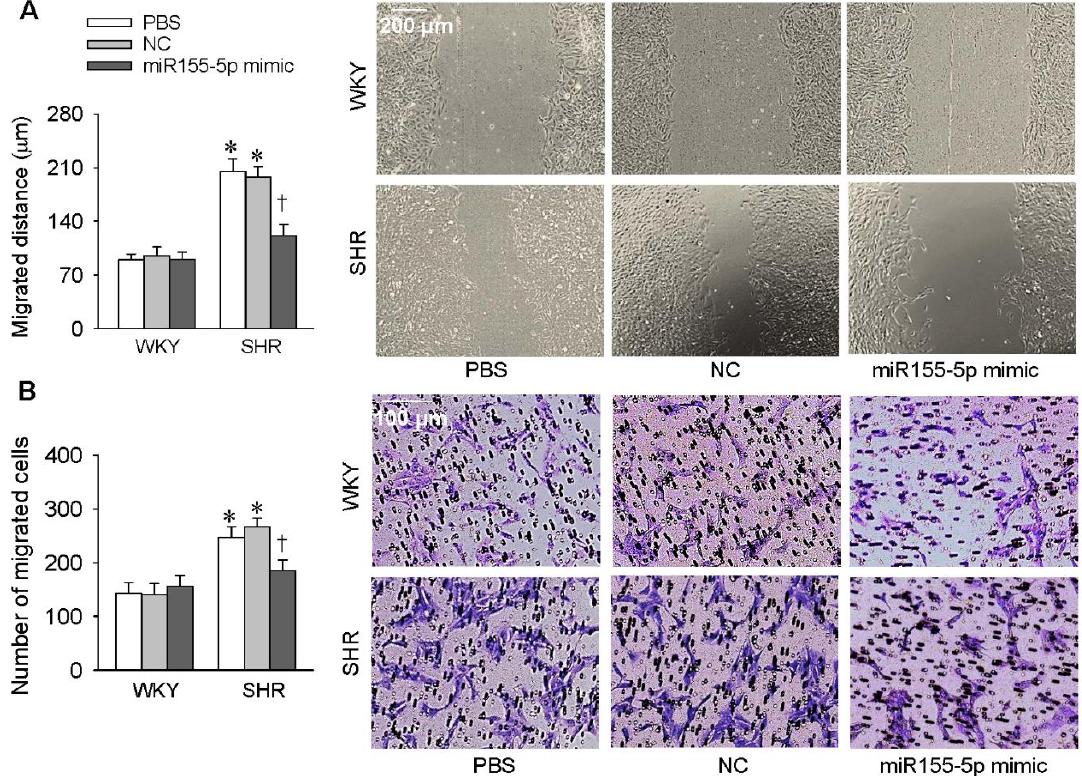
Figure 1. Effects of the miR155-5p mimic on vascular smooth muscle cells (VSMC) migration. VSMCs derived from Wistar-Kyoto (WKY) rats and spontaneously hypertensive rats (SHR) were treated with PBS, negative control (NC), or the miR155-5p mimic (50 nmol/L). Measurements were made 24 h after transfection. ( A ) VSMC migration evaluated by a wound healing assay. ( B ) VSMC migration evaluated by the Boyden chamber assay. Values are mean ± SE; * p < 0.05 vs. WKY; † p < 0.05 vs. PBS or NC; n = 6 per group.